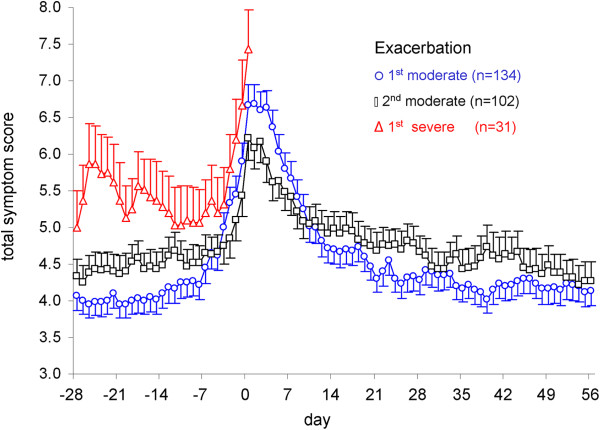
Mean total symptom scores (with SEM) from diary cards according to day number before (days −28 to 0) and after (days 1 to 56) the onset of an exacerbation. Day 0 marks the recorded day of the onset of an exacerbation in the clinical record form. Circles, squares and triangles denote the 1st moderate, 2nd moderate and 1st severe exacerbation, respectively. Outcomes for the 1st severe exacerbation are graphed only up to the day of onset because of many missing values after its onset (when patient were admitted to the hospital).